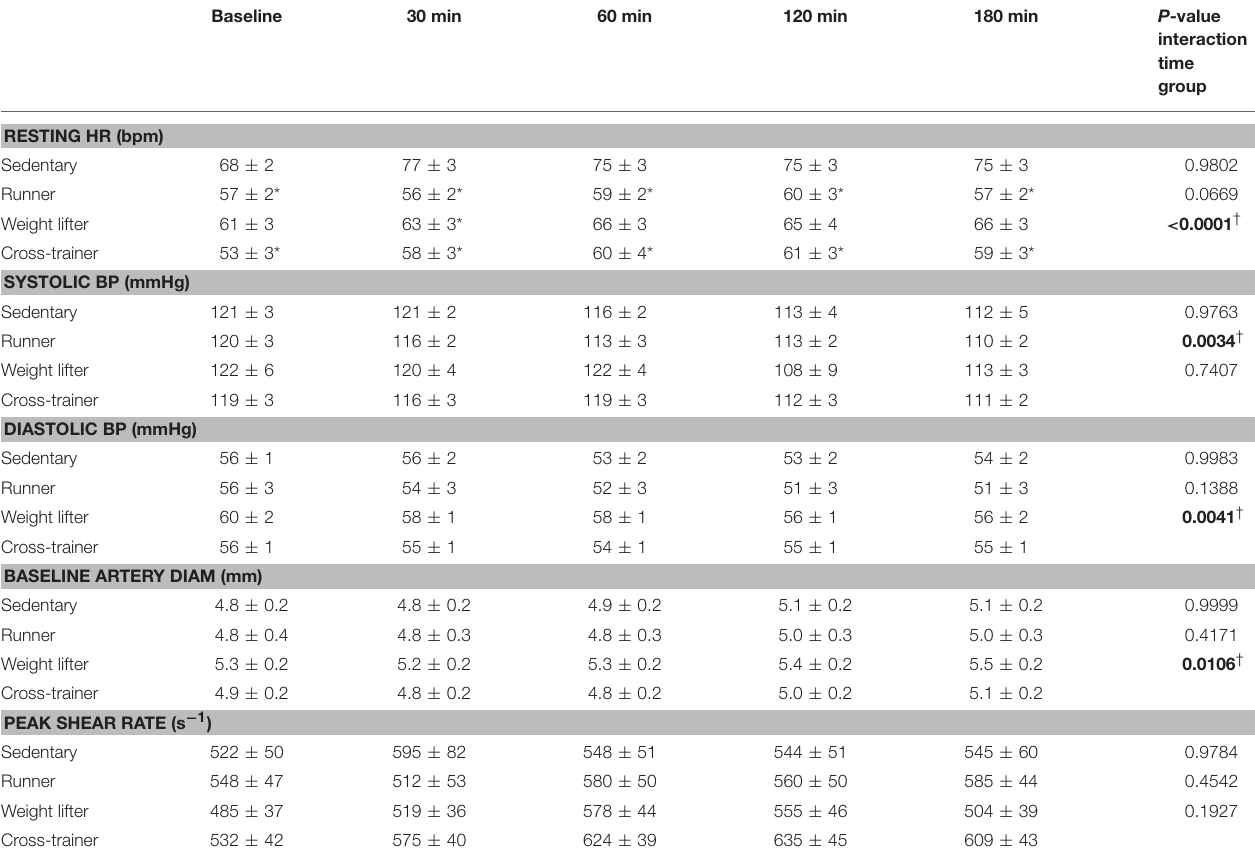
TABLE 3 | Data are presented as mean ±